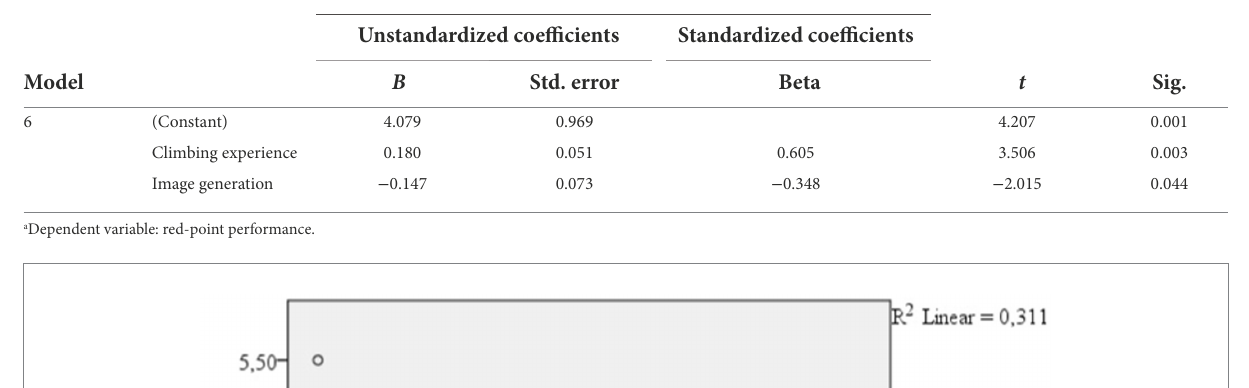
TABLE 11 Coefficients for predicting red-point